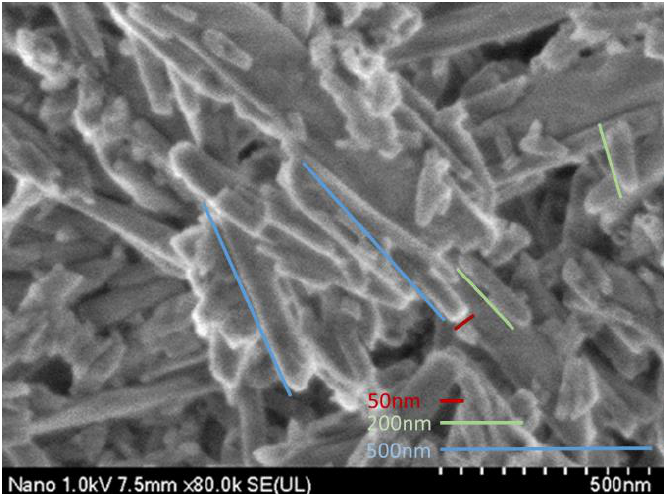
Figure 5. Halloysite nanotubes.